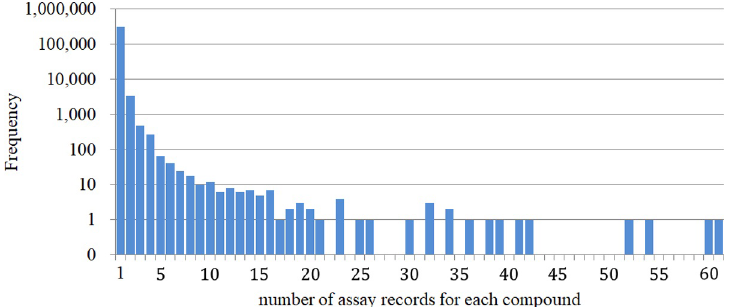
Fig 2. Histogram showing the number of assay records for each compound. The vertical axis representing the frequency is shown in logarithmic scale.